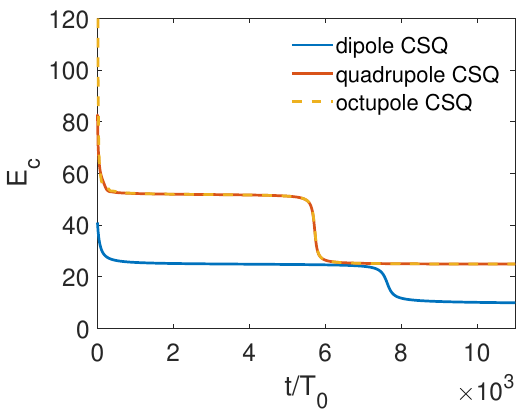
Figure 24. Energy evolution of different multipole CSQs. The initial distances between constituent Q-balls and the coordinate origin are: 2 for the dipole CSQ, 4 for the quadrupole CSQ and 8 for the octupole CSQ, in units of 1 /m . The frequencies of constituent Q-balls are all chosen to be ω = 0 . 84 .